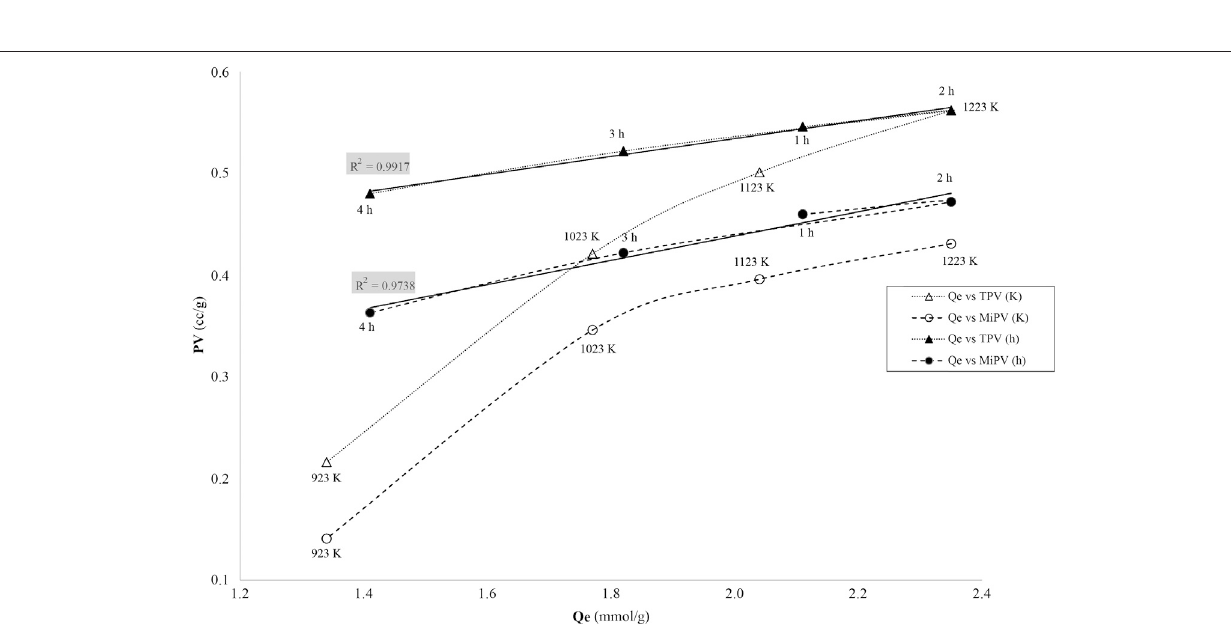
FIGURE 8 | Relationship between amount of MB adsorbed (q e ) and the total pore volume, TVP, and the micropore volume, MiPV, for four activated carbons at different temperatures and the four activated carbons at different holding